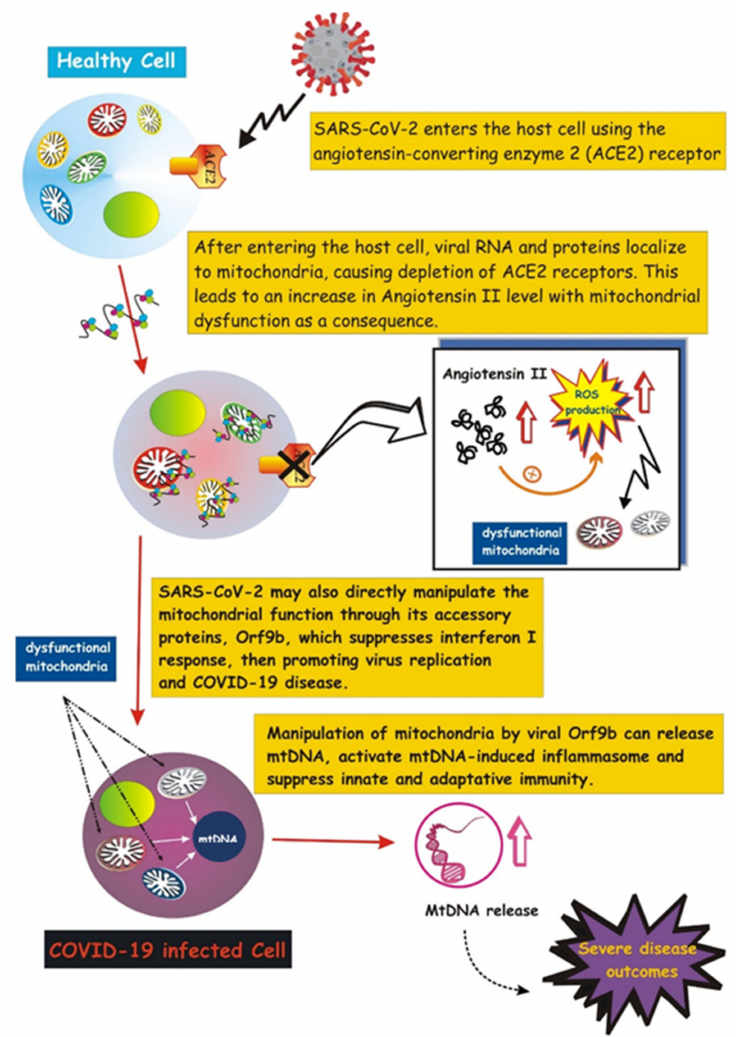
Figure 4. Involvement of mitochondria in COVID-19 pathogenesis. Schematic illustration showing the SARS-CoV-2 entry into the host cell by attaching to angiotensin-converting enzyme carboxypepti- dase 2 (ACE2). Once inside the cell, viral RNA and proteins localize on mitochondria, resulting in ACE2 depletion and increase in Angiotensin-II, which, in turn, mediates mitochondrial dysfunction (more details in the text). SARS-2-CoV-2 targets the mitochondrial machinery also directly through one of its encoded proteins, Orf9, which promotes release of mtDNA and further mitochondrial dysfunction, leading to enhanced inflammasome